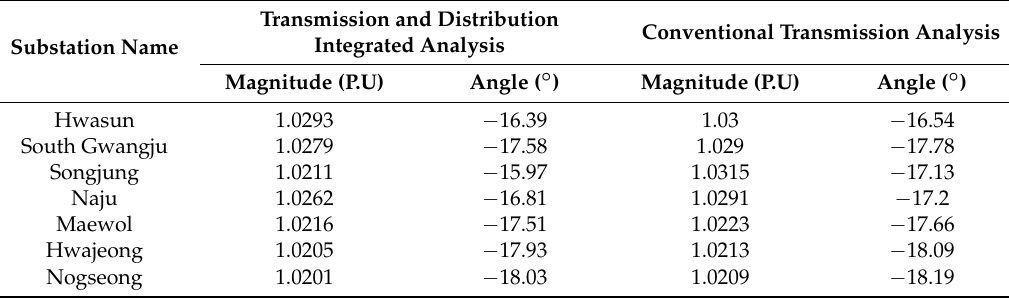
Table 1. Comparison between the conventional transmission analysis and integrated method.